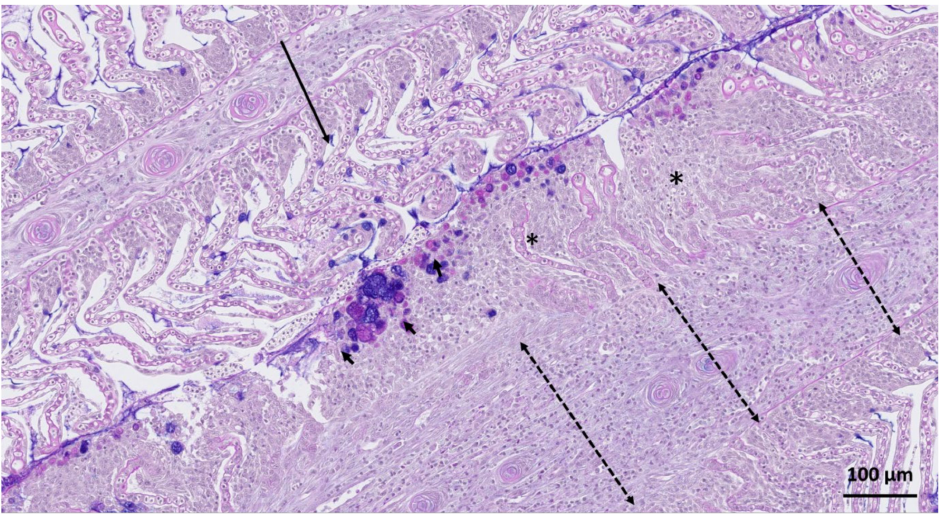
Figure 5. Histomicrograph of PAS-Alcian blue stained sections of gill. A mild to moderately affected gill filament (long arrow) was noted next to a filament with severe lesions (asterisk). In the severely affected filament lamellae were fused and an increased number of mucous cells were noted at the peripheral margin of the gill epithelium (solid arrows). The gill filament (dashed arrows) display a large influx of eosinophilic granular cells and mononuclear